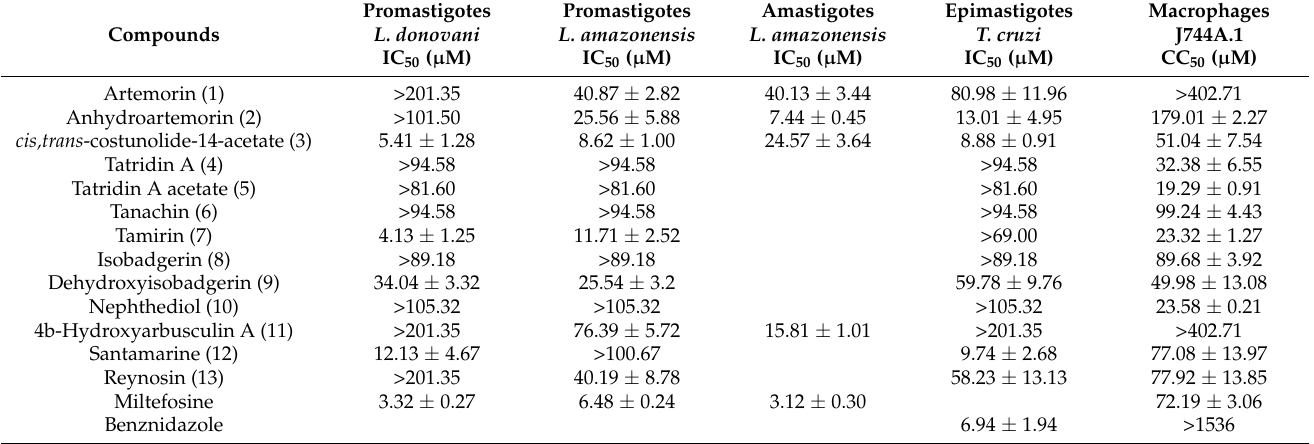
Table 1. Effects of compounds 1 – 13 isolated from the coral Palythoa aff. clavata against kinetoplastid species and murine macrophages (J744A.1). The IC 50 results correspond to 72 h of incubation in T. cruzi epimastigotes and Leishmania spp. promastigotes, and to 24 h of incubation in the case of macrophages and L. amazonensis amastigotes. Inhibitory concentrations are reported in µ M and miltefosine and benznidazole included as reference treatments. Values represent mean concentrations with each standard